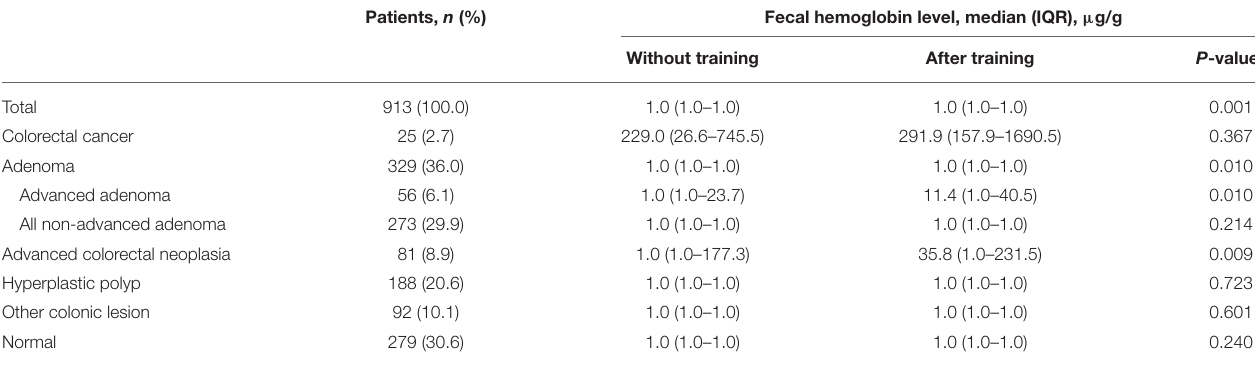
TABLE 3 | The distribution of the concentration of the hemoglobin (Hb) of the qFIT without and after the practical sample collection operant training. Patients, n (%) Fecal hemoglobin level, median (IQR), µ g/g Without training After training P -value*